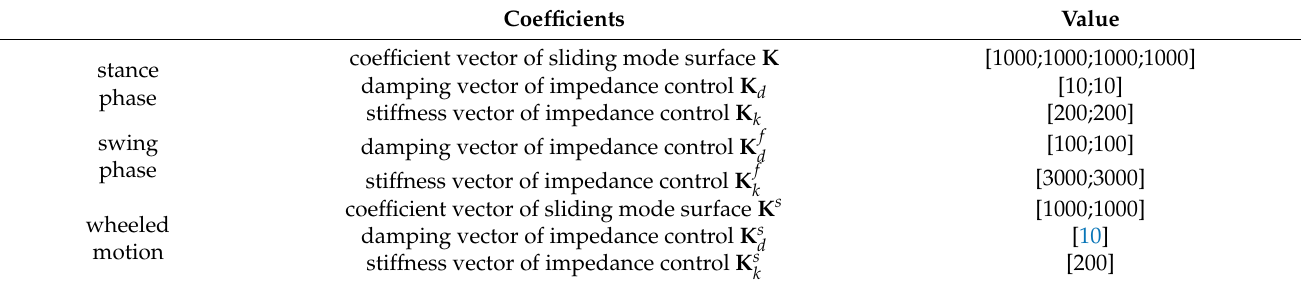
Figure 8. Simulation model of the wheel-legged robot. Table 3. Coefficients of TeCVP.